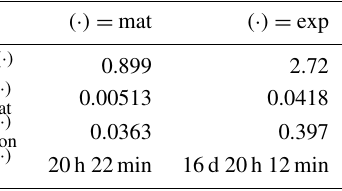
Table 4. Covariance function parameter values learned from OCO- 2 data. First column shows the Matérn kernel parameters, and the second column shows the exponential kernel parameters. The spa- tial length-scale parameters are given as distance on the unit sphere, with 0 . 01 corresponding to approximately 64km. The length scales · ) along the parallels, (cid:96) ( , are much larger than that along the merid- lon · ) ians, (cid:96) ( lat